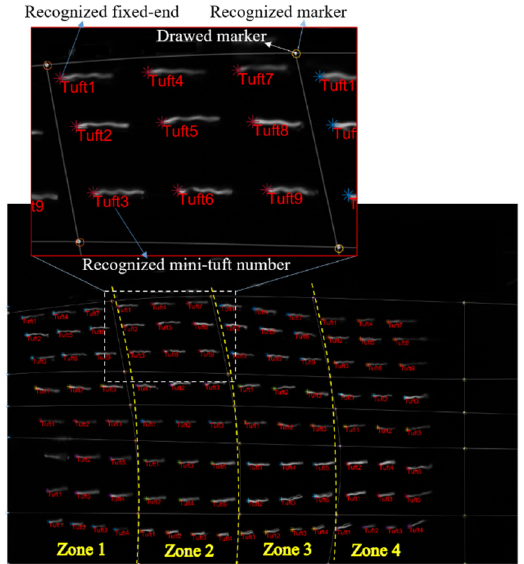
Figure 7. Recognized mean mini-tufts classification.